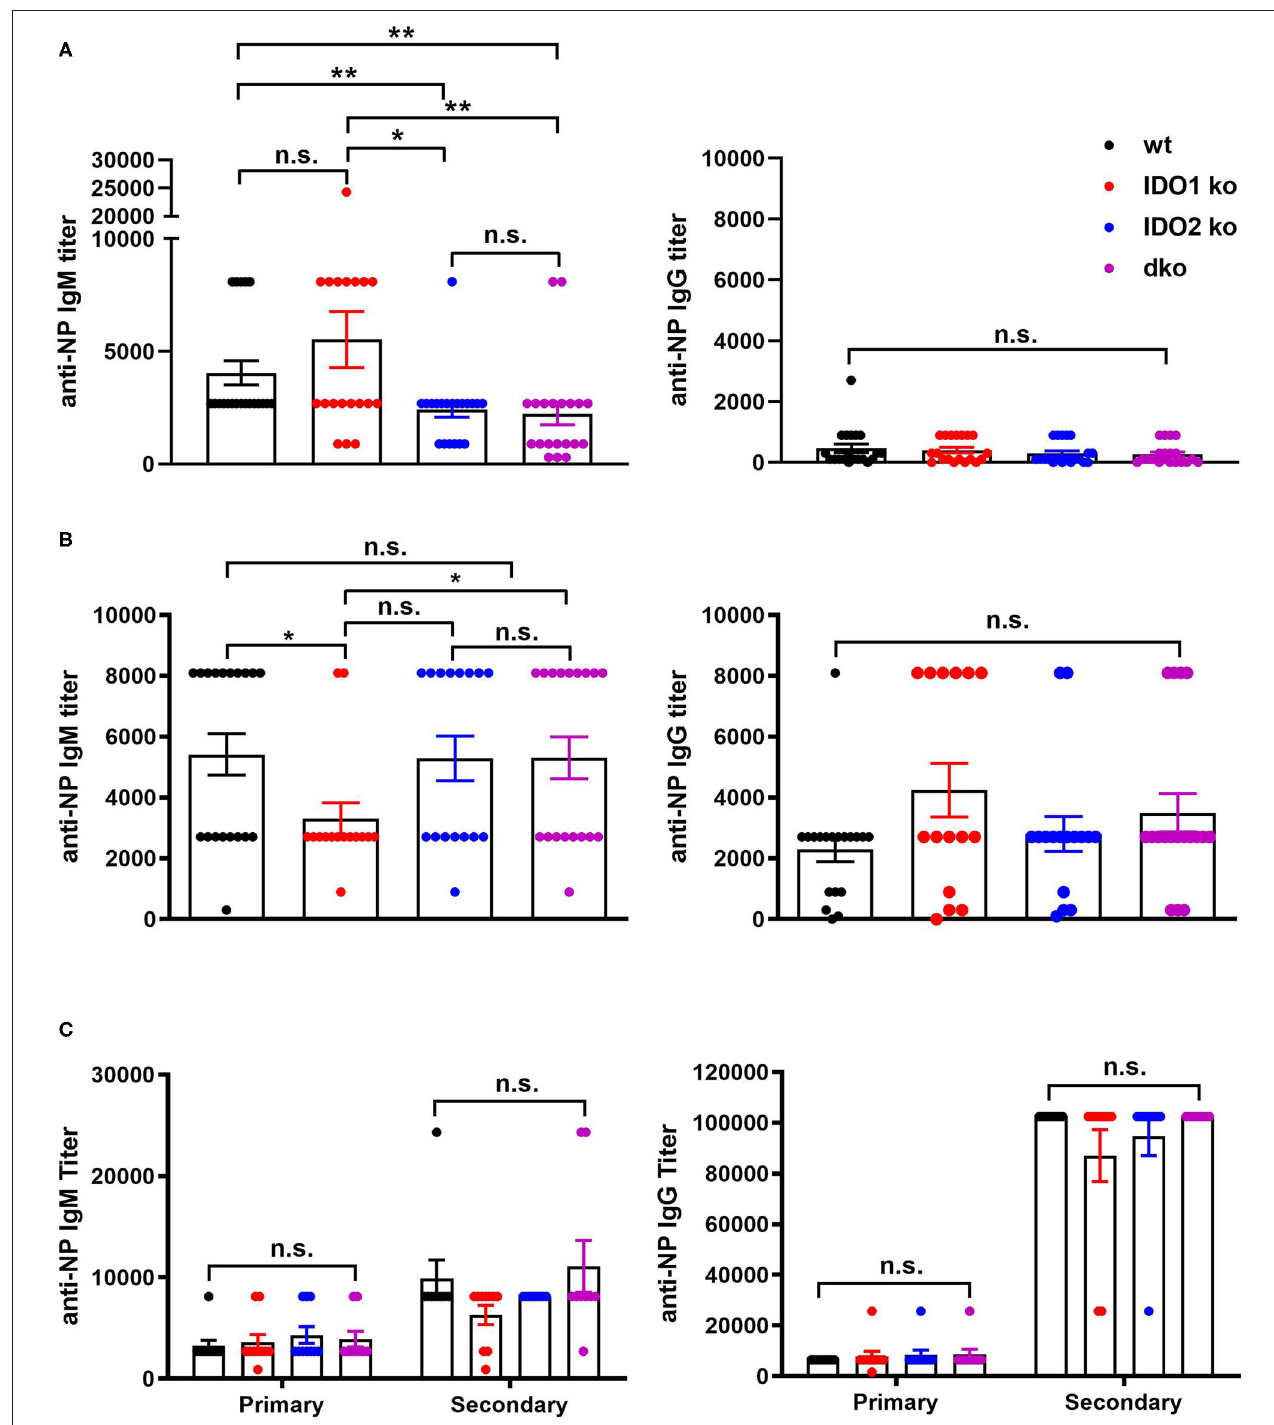
FIGURE 8 | IDO2 ko and dko mice generate reduced antibody responses to T-independent type II, but not T-independent type I or T cell dependent responses. Wt, IDO1 ko, IDO2 ko, and dko C57BL/6 mice were immunized with (A) NP-Ficoll, (B) NP-LPS, or (C) NP-KLH and high affinity anti-NP titers measured by ELISA on day 7 (NP-Ficoll, NP-LPS) or day 10 after the primary and secondary responses (NP-KLH). Symbols represent individual mice and histograms show mean ± SEM of the reciprocal of serum anti-NP IgM and IgG titers from n = 20 mice per group for NP-Ficoll, pooled from 4 independent experiments; n ≥ 15 mice per group for NP-LPS, pooled from 3 independent experiments, and n = 10 mice per group for NP-KLH, pooled from 2 independent experiments. Individual symbols may overlap for mice with identical titers. P -values were calculated using a Mann-Whitney non-parametric test. * p < 0.05, ** p < 0.01, n.s., not significant.